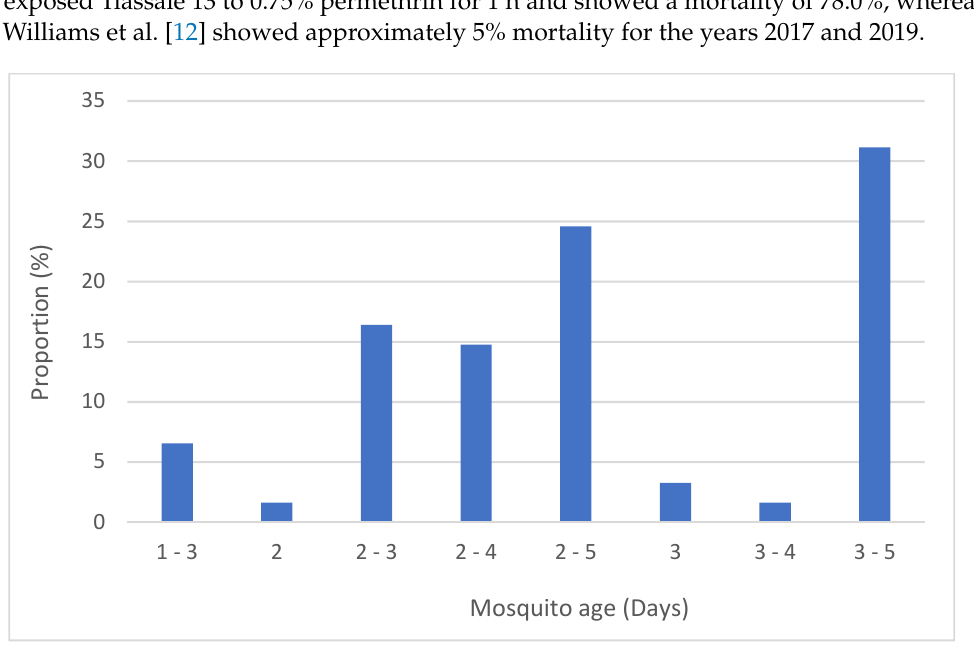
Figure 5. The age of mosquitoes tested for publications reviewed.